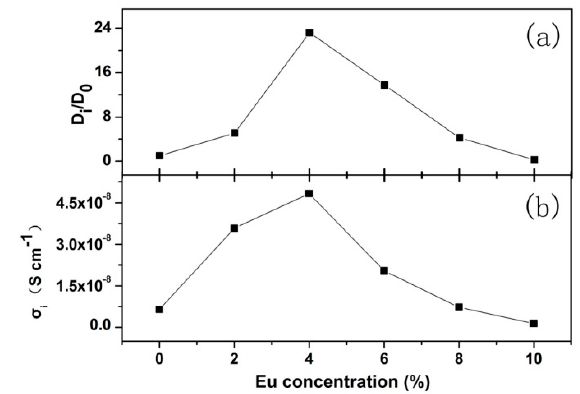
Figure 6. The variation of the ionic diffusion coefficient ( a ) and conductivity ( b ) with the Eu-doping concentration.